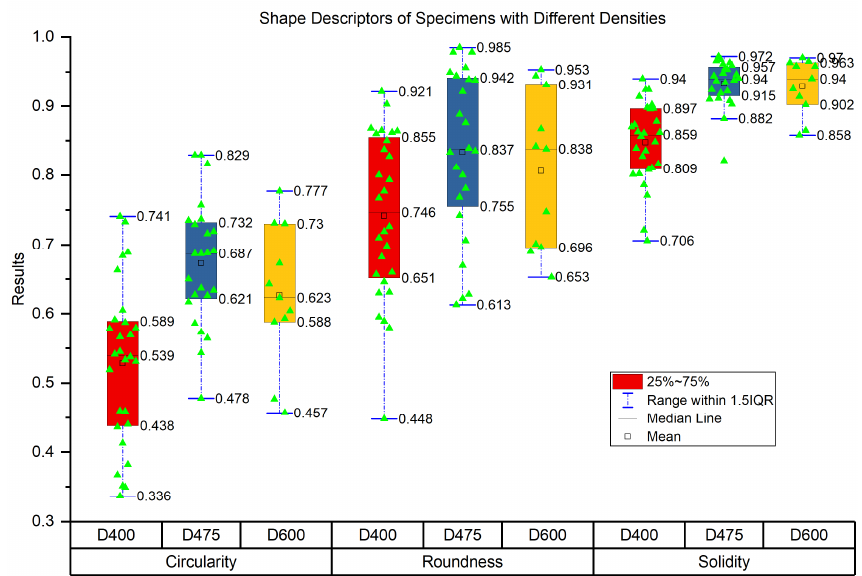
Figure 10. Data of shape descriptors of specimens with different densities.